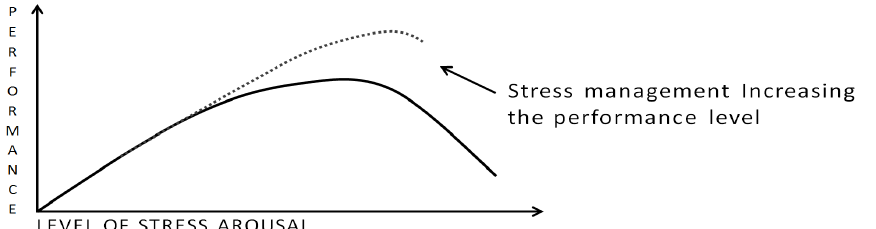
Fig. 11. Simplified illustration of stress management as a method to increase performance level without adding on stress